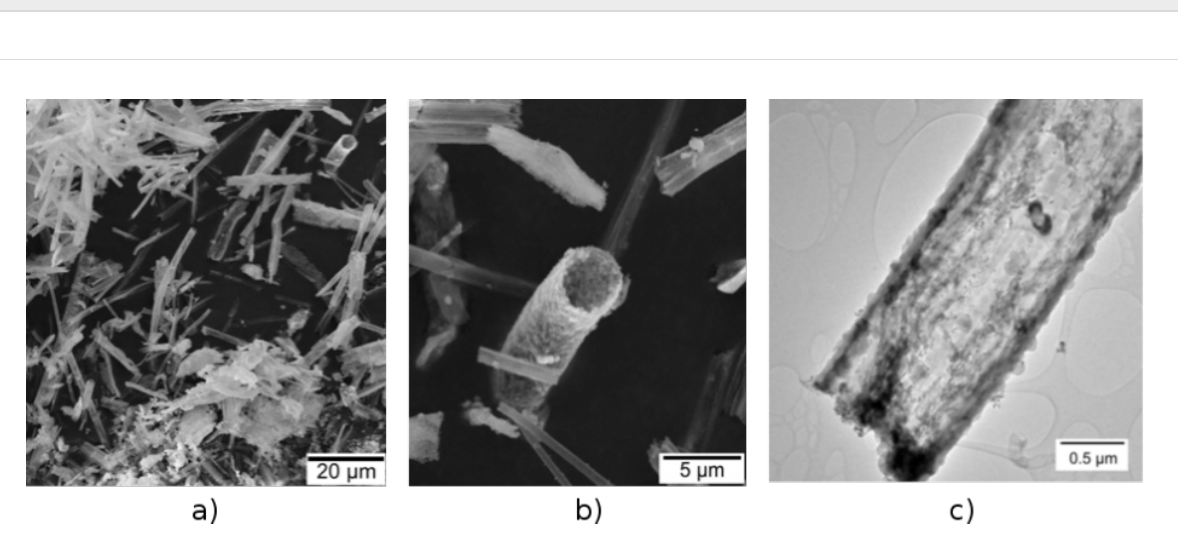
Figure 1: a) SEM image of electrospun PS template fibers; b) and c) SEM at two different magnifications of microsized silica tubes after calcination (750 °C, 4 h). The silica tubes are obtained by using electrospun PS fibers as exotemplates, functionalizing them by an O 2 plasma treatment followed by coverage with a layer of Stoeber sol particles. The average diameter of the silica tubes is ca. 2 µm. However, smaller tubes exist due to the non- uniform electrospinning process yielding the PS tubes. The inset in c) shows a HRTEM picture of the silica side wall of an individual tube depicting its amorphous character.